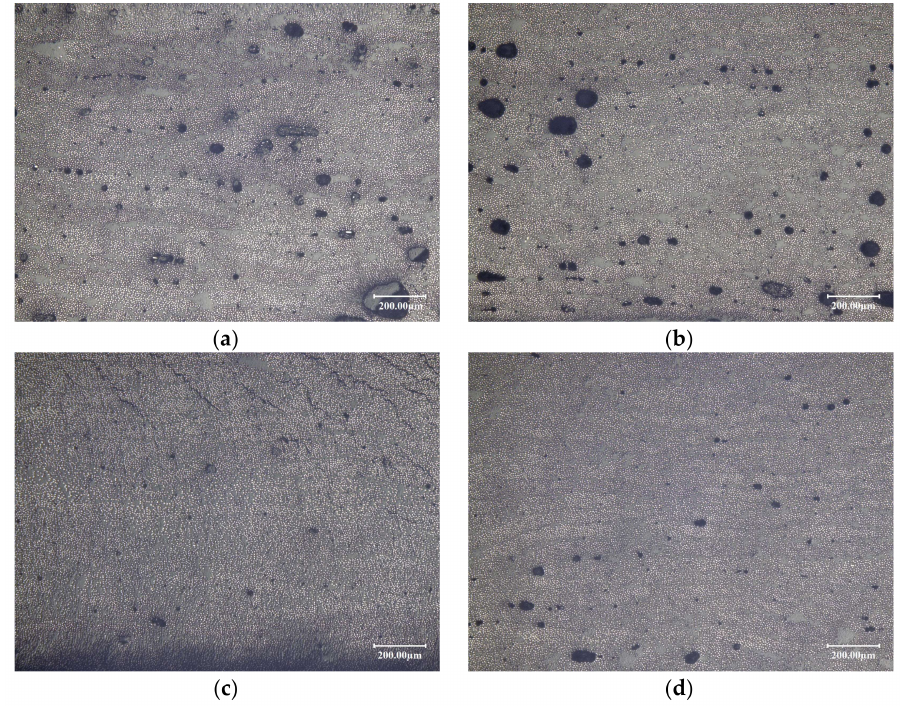
Figure 7. Manufacturing defects and identification of void content: ( a ) void content of 3.45% at S of 10 mm · s − 1 , F of 850 N, and T of 50 ◦ C; ( b ) void content of 4.48% at S of 15 mm · s − 1 , F of 850 N, and T of 60 ◦ C; ( c ) void content of 0.41% at S of 10 mm · s − 1 , F of 350 N, and T of 40 ◦ C; and ( d ) void content of 0.82% at S of 15 mm · s − 1 , F of 600 N, and T of 50 ◦